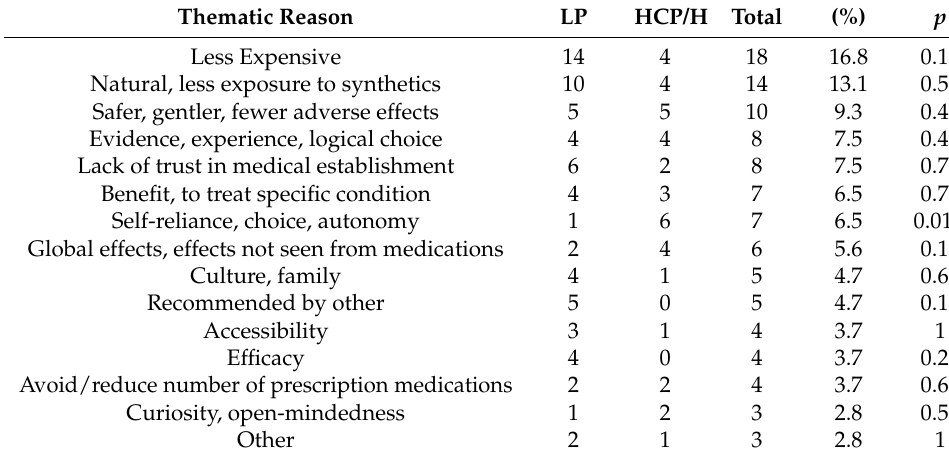
Table 2. Reasons for HDS use. Percent total represents the number of responses in thematic categories compared to total number of